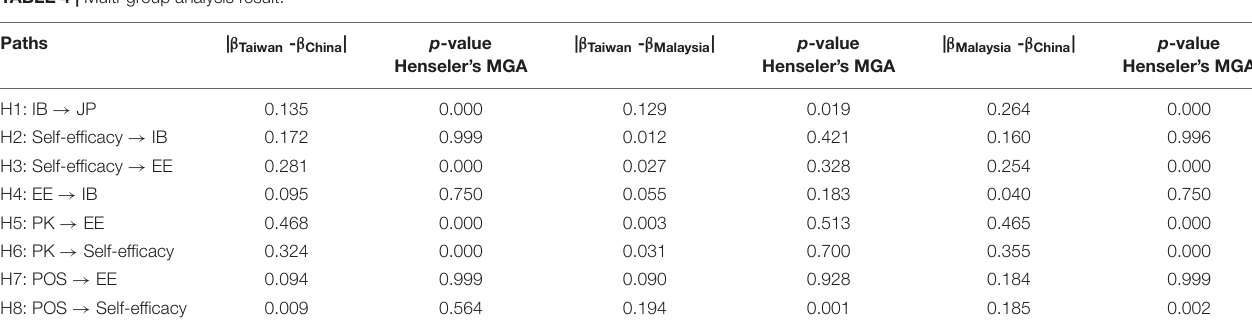
FIGURE 4 | Structural model on Malaysian employees. PK, prior knowledge; POS, perceived organizational support; EE, employee employability; IB, innovation behavior; JP, job performance. *** p < 0.001. TABLE 4 | Multi-group analysis